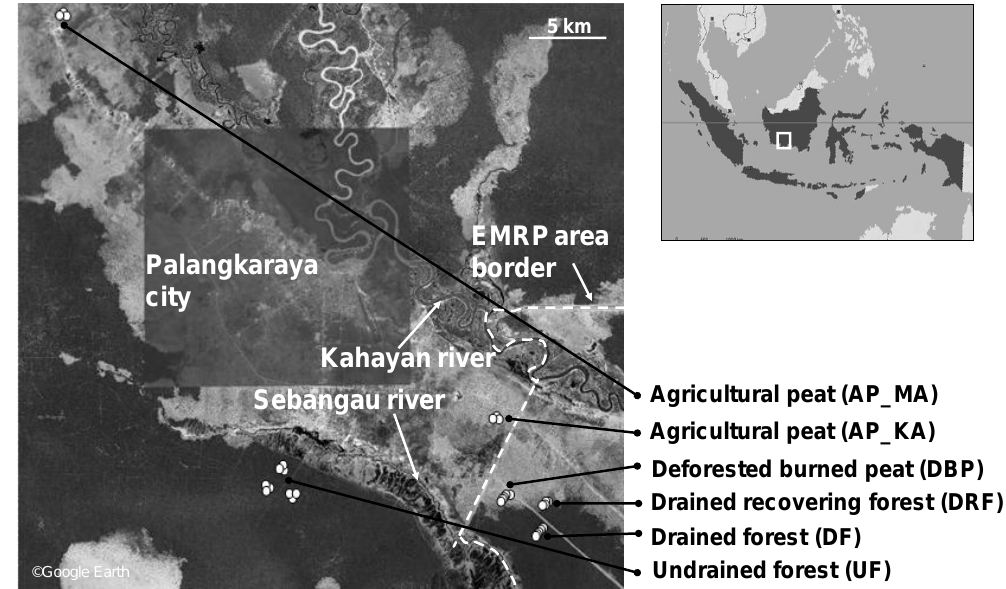
Fig. 1. Greenhouse gas flux monitoring sites in Central Kalimantan, Indonesia. North-East border of Ex-Mega Rice Project area is outlined by the white dotted line.